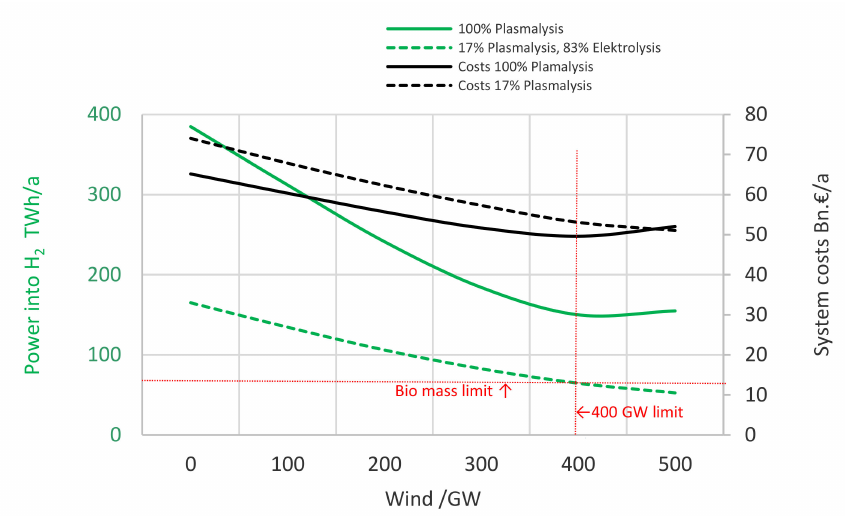
Figure 7. Hydrogen from biomass leads to lower system costs. The available biomass sets a limit of 17% for installed plasmalysis power; the rest is left for electrolysis.